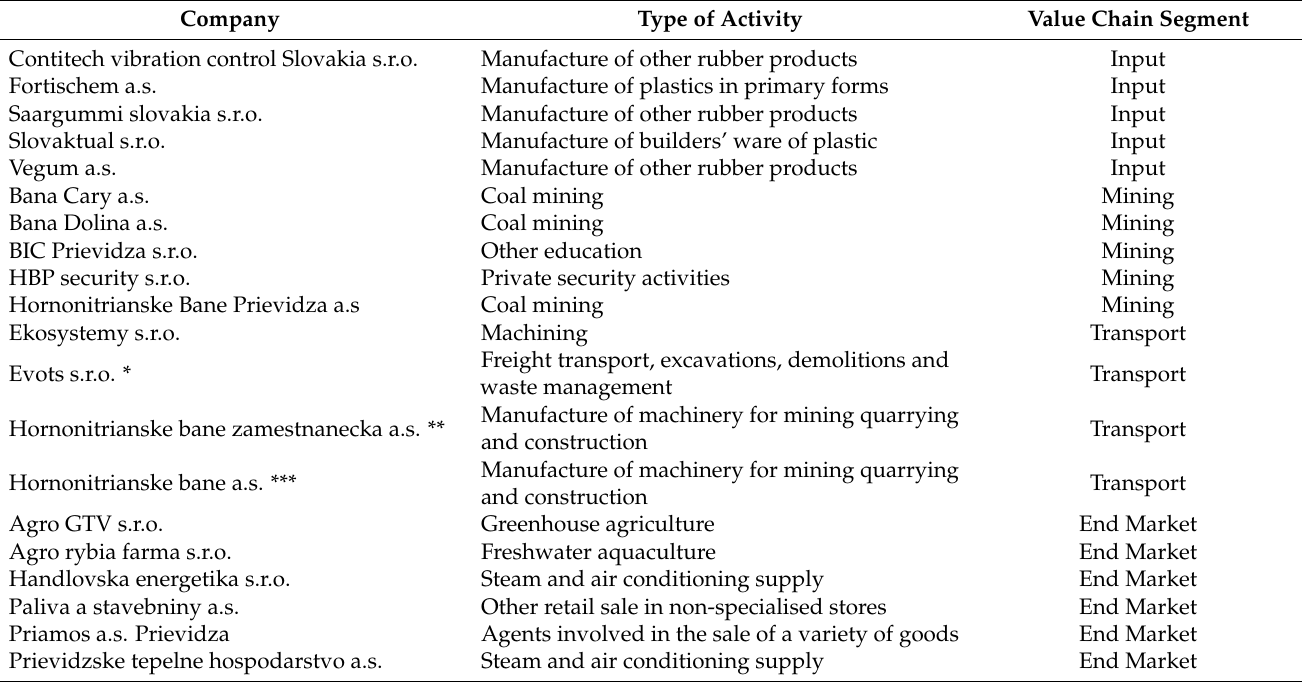
Table A1. The list of companies included in the financial